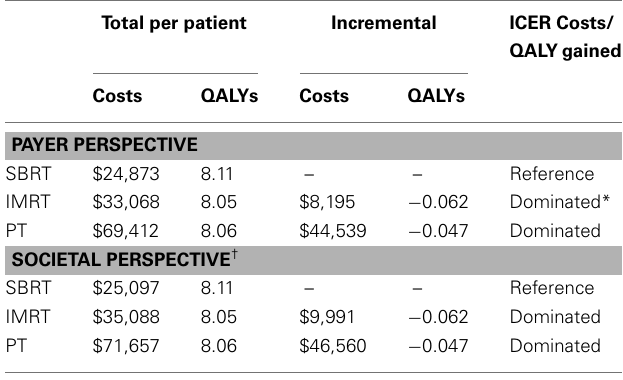
Table 6 | Cost-effectiveness results for all comparator treatments for the base-case.